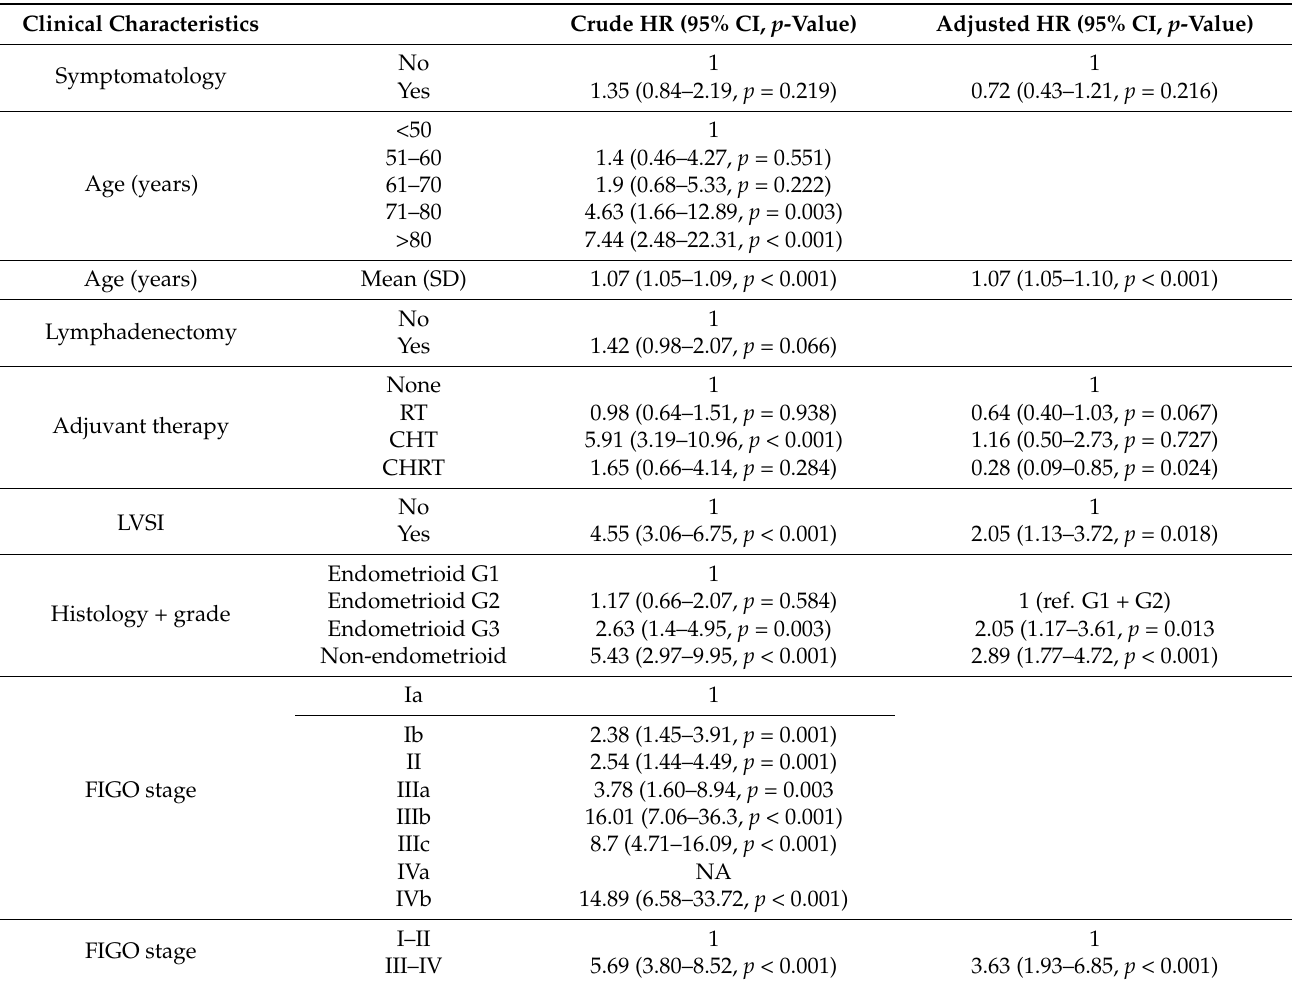
Table 3. Overall survival—univariable and multivariable Cox proportional hazards